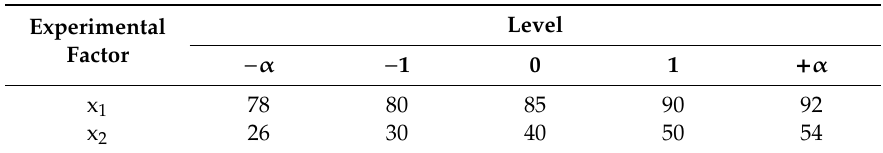
Table 1. Selected experimental factors for release antioxidant compounds from Zingiber o ffi cinale by ultrasound-assisted extraction at the desired